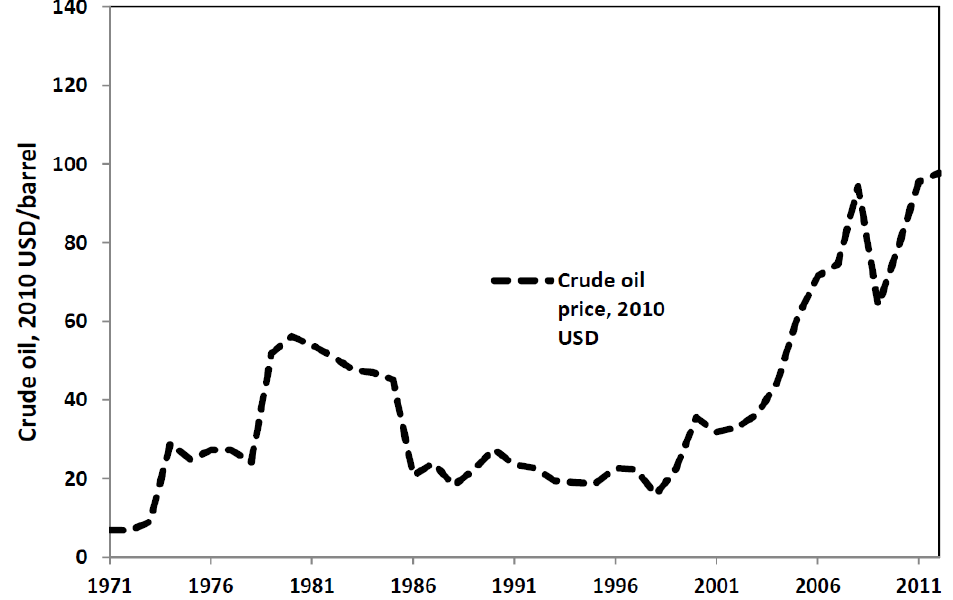
Figure 4. Annual average crude oil prices 1971–2012